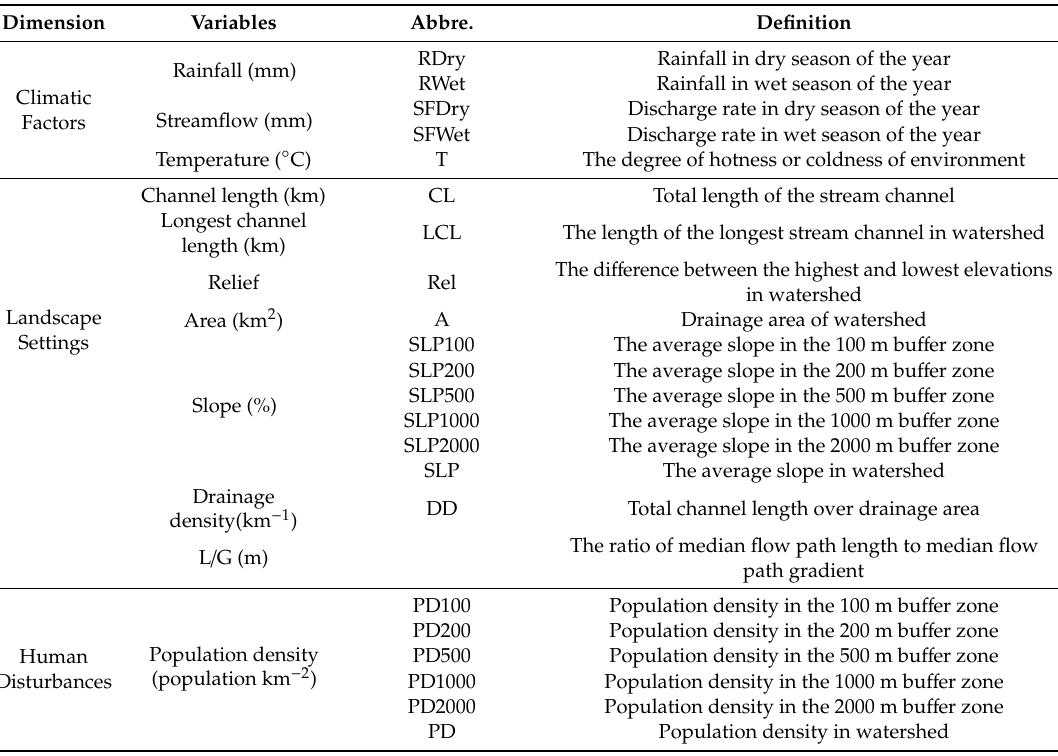
Table 1. Definition of di ff erent variables used in the three dimensions. Abbre. = abbreviation. Dimension